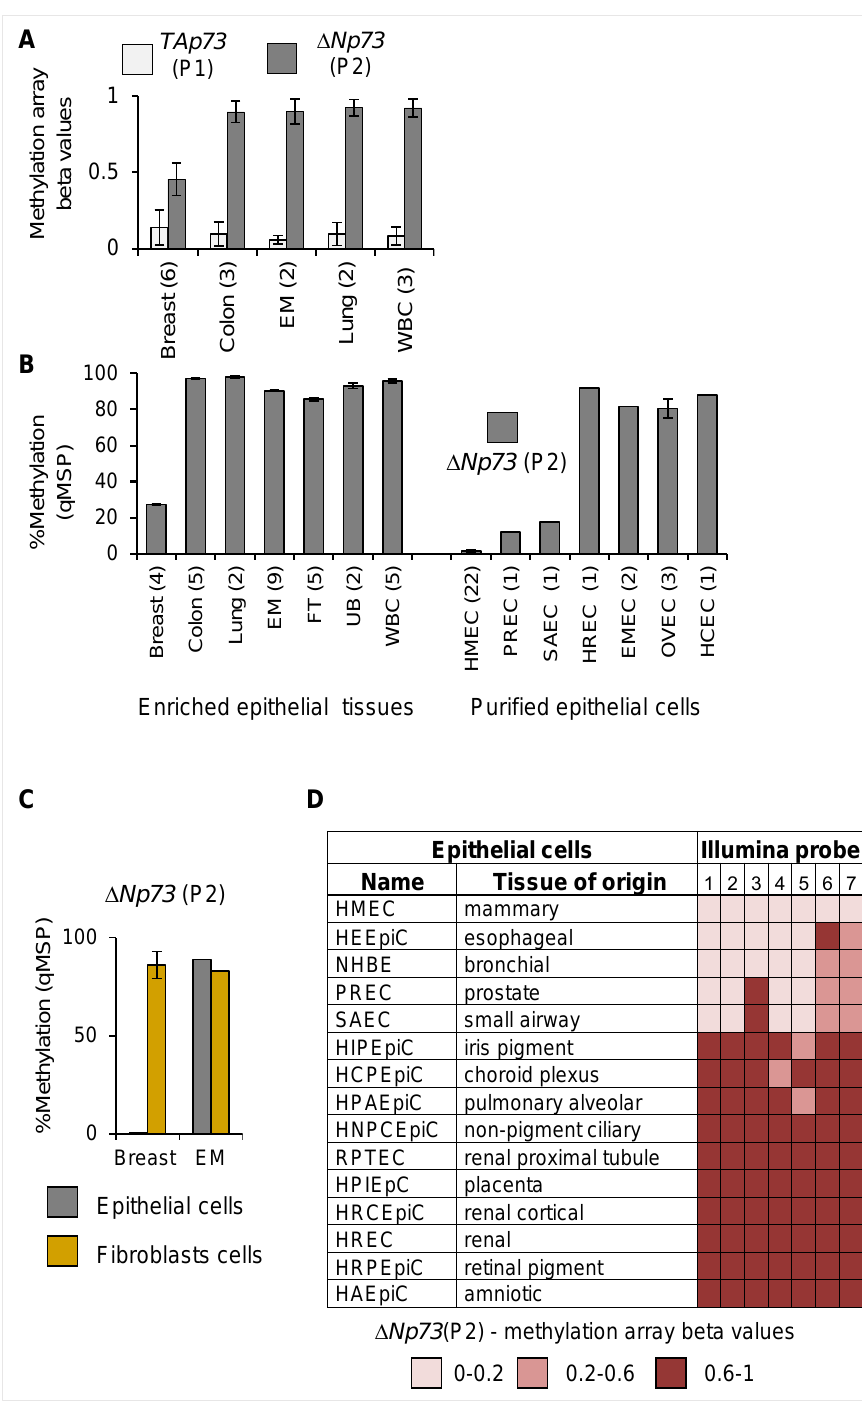
Figure 1. Tissue-specific DNA methylation of the deltaNp73 promoter (P2) in normal human epithelial tissues and primary cells. ( A ) DNA methylation of the TP73 promoters (P1 and P2) analyzed by Illumina methyl27K array. Data represent average beta values from 0 to 1 (non-methylated to fully methylated) ± S.E.M. ( B ) DNA methylation of the deltaNp73 promoter (P2) measured by quantitative methylation-specific PCR (q-MSP) in various normal human epithelial tissues and purified primary epithelial cells. Data represent mean ± S.E.M. ( C ) Di ff erential DNA methylation at the deltaNp73 promoter (P2) in epithelial cells and in matched fibroblasts from breast ( n = 3) or endometrial (EM, n = 1) tissues of the same individual. ( D ) DNA methylation of the deltaNp73 (P2) promoter in